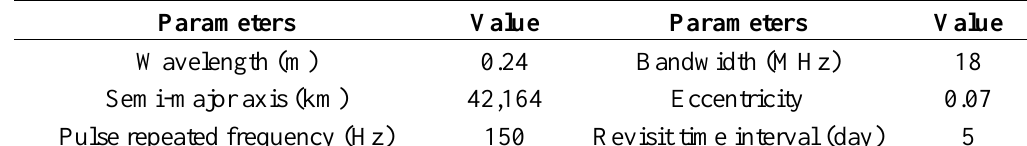
Table 5. GEO SAR system parameters.